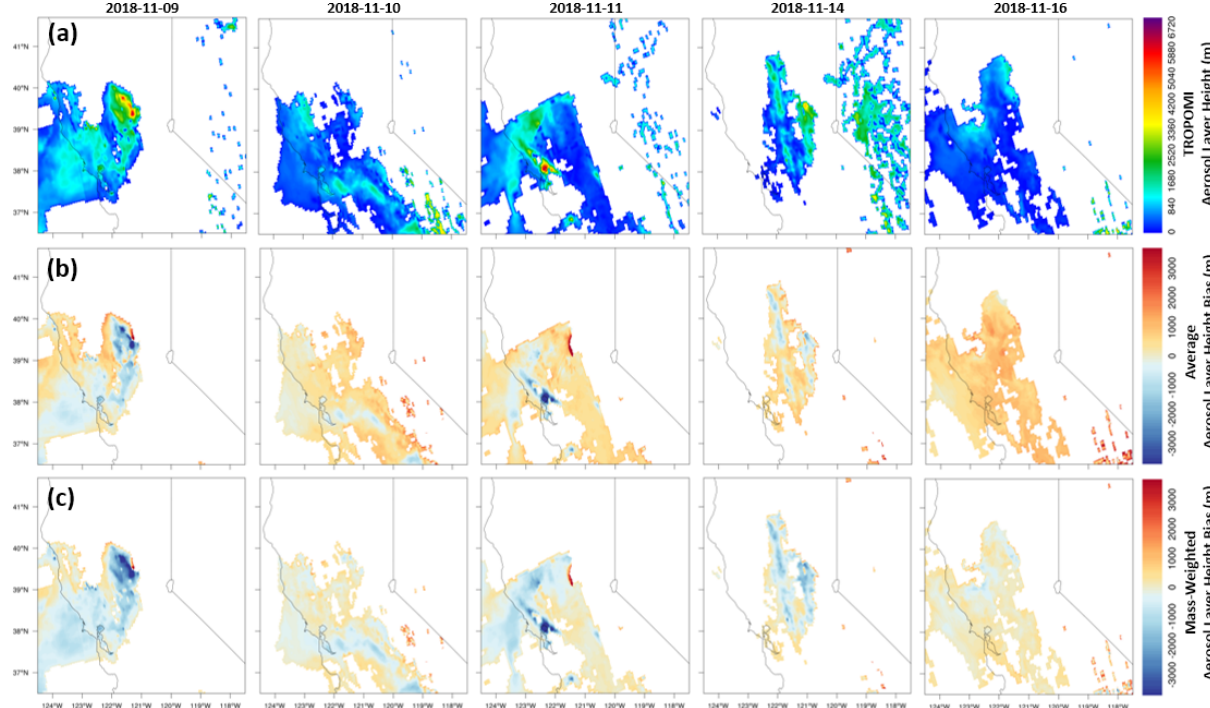
Figure 11. Comparison of TROPOMI aerosol layer height (a) and bias where S_CTRL layer height is calculated as the average of heights where PM 2 . 5 > 3µgm − 3 (b) and the average weighted by PM 2 . 5 mass (c) for select days at 13:30LT. In panels (b) and (c) , warm colors indicate positive bias where S_CTRL overpredicts the height of the aerosol